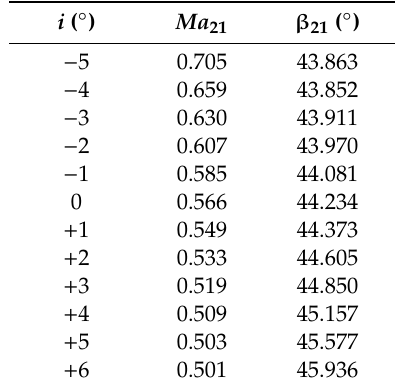
Table 3. The aft blade (AB) inlet conditions.